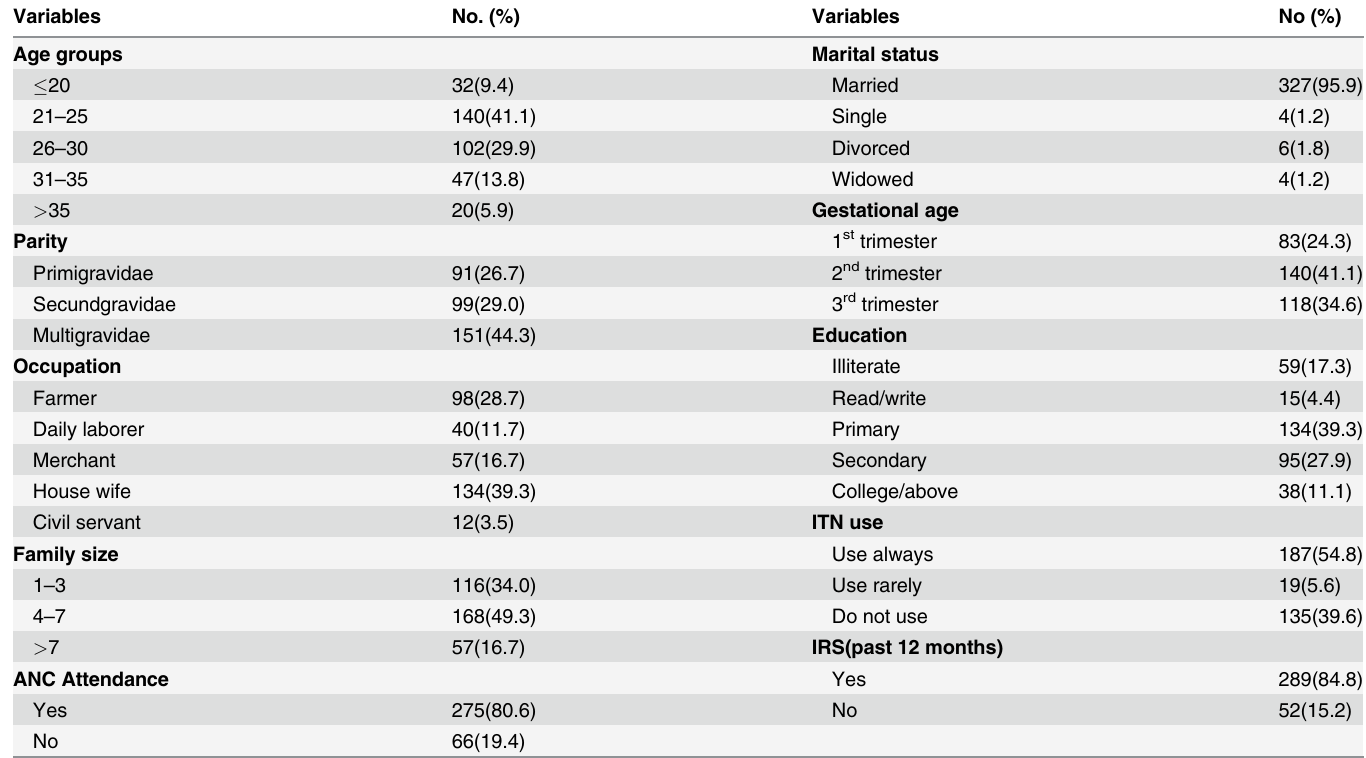
Table 1. Socio-demographic characteristics of the pregnant women in the rural surroundings of Arbaminch Town, south Ethiopia between April and June 2013. Variables